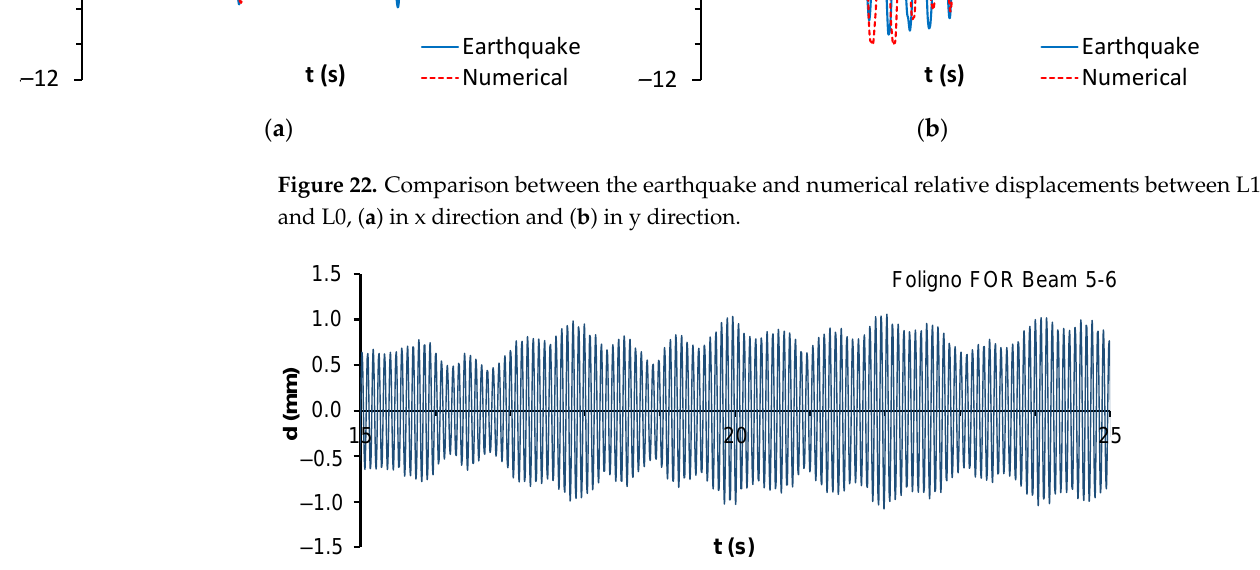
Figure 23. Relative displacement between the beams 5-6 of the first floor and of L1 in vertical direc- tion.